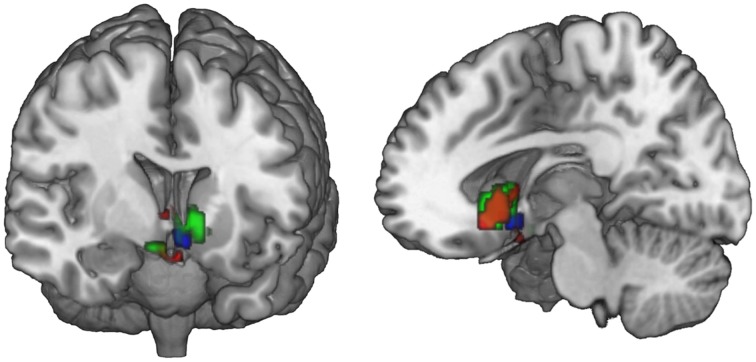
Ventral striatal subregions responding value-independently and value-dependently. In the ventral striatum, voxels that are active in response to the FT product (that may be due to salience or general responses to an FT label) are distinct from value-dependent voxels that correlate with the increment value of the FT product. In green, voxels are depicted that are activated in response to the FT vs. conventional product (GLM 1). The red voxels depict the activation in response to the FT product over and above what is already explained by WTP (GLM 2). The blue voxels correlate with the increment value of the FT product at the time of FT product presentation (GLM 3). In sum, a broader and more lateral part of the striatum is activated value-independently (GLM 2, green), and a smaller and more medial and ventral part is activated value-dependently (GLM 3, blue). Data are shown using MRIcroGL (MNI template) and in radiological convention.